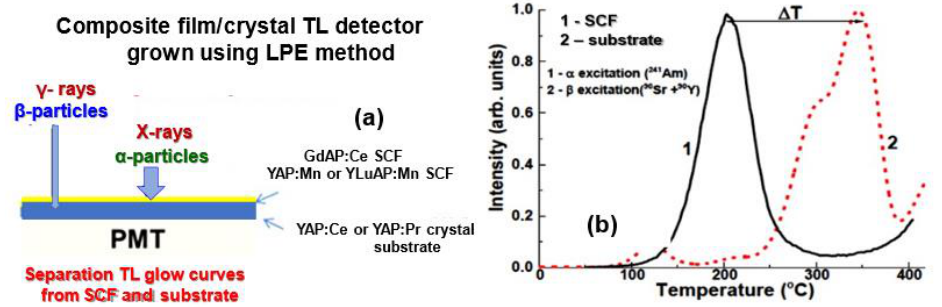
Figure 1. ( a ) Scheme of a two-layer composite TL detector, ( b ) Example of recording ΔT tempera-ture difference between the main peaks in TL glow curves of the film and substrate in a composite TL material.